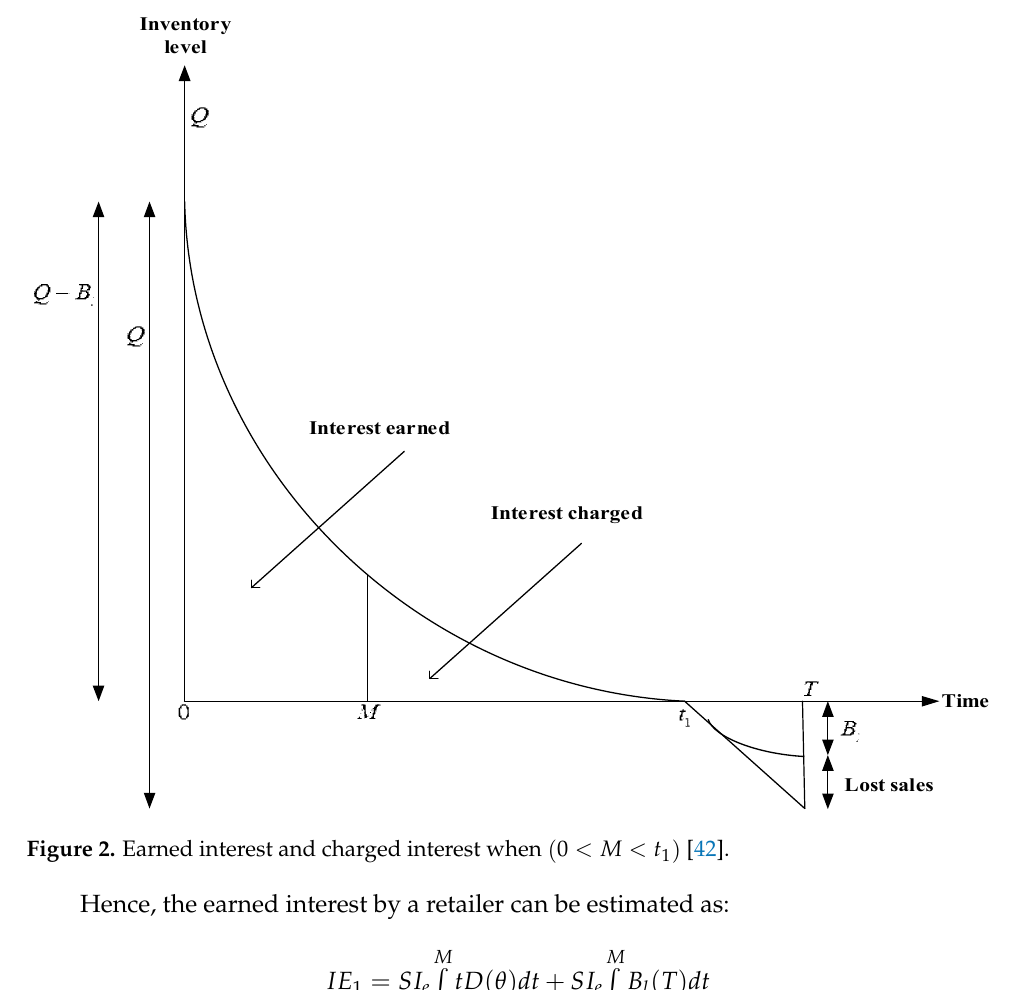
Figure 2. Earned interest and charged interest when ( 0 < M < t 1 )